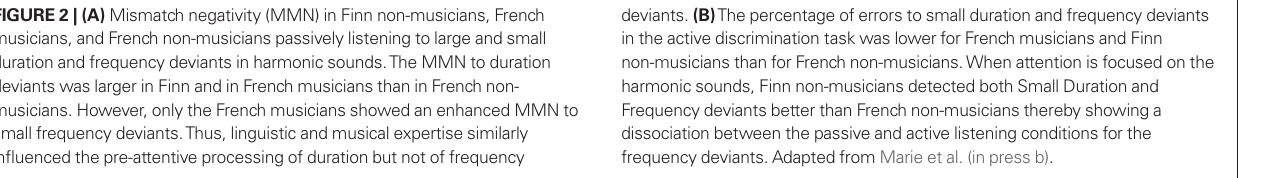
deviants. (B) The percentage of errors to small duration and frequency deviants in the active discrimination task was lower for French musicians and Finn non-musicians than for French non-musicians. When attention is focused on the harmonic sounds, Finn non-musicians detected both Small Duration and Frequency deviants better than French non-musicians thereby showing a dissociation between the passive and active listening conditions for the frequency deviants. Adapted from Marie et al. (in